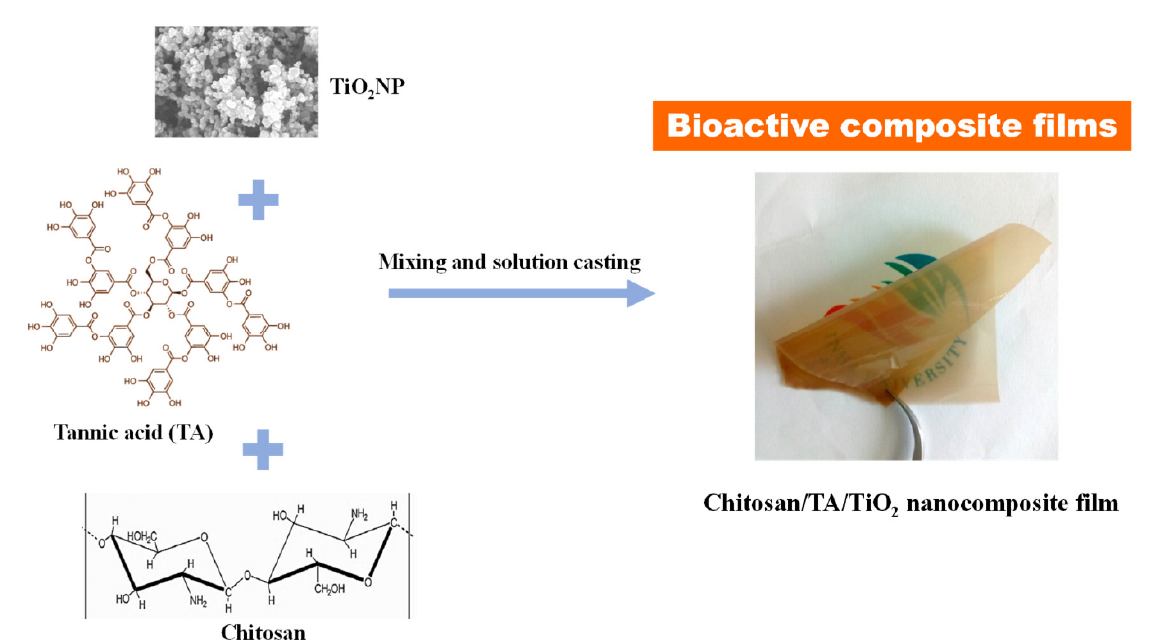
Figure 10. Representative process for the development of nanocomposite films (taken from [20] under Creative Commons License).